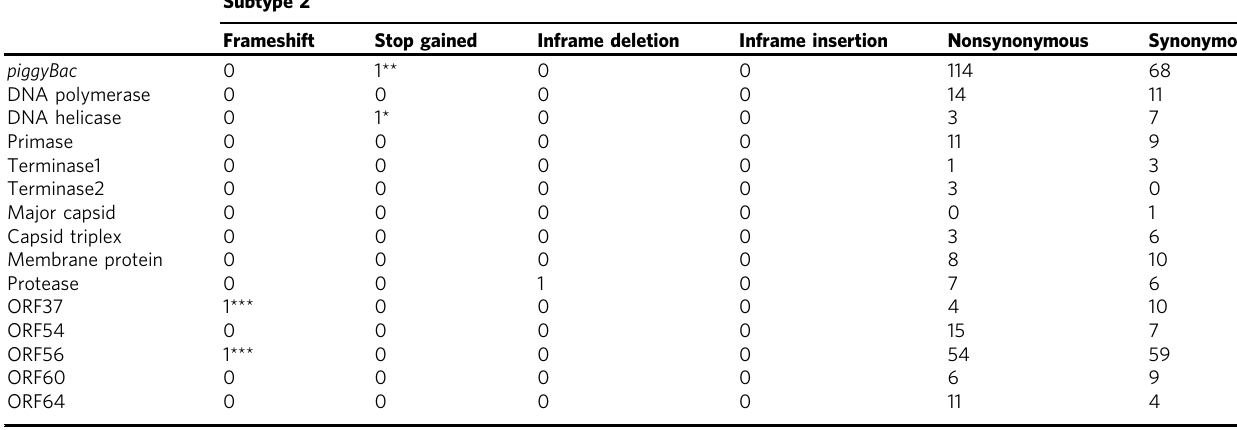
Table 2 Number of variants at the core herpesvirus genes among all subtype 2 Teratorn copies in the medaka